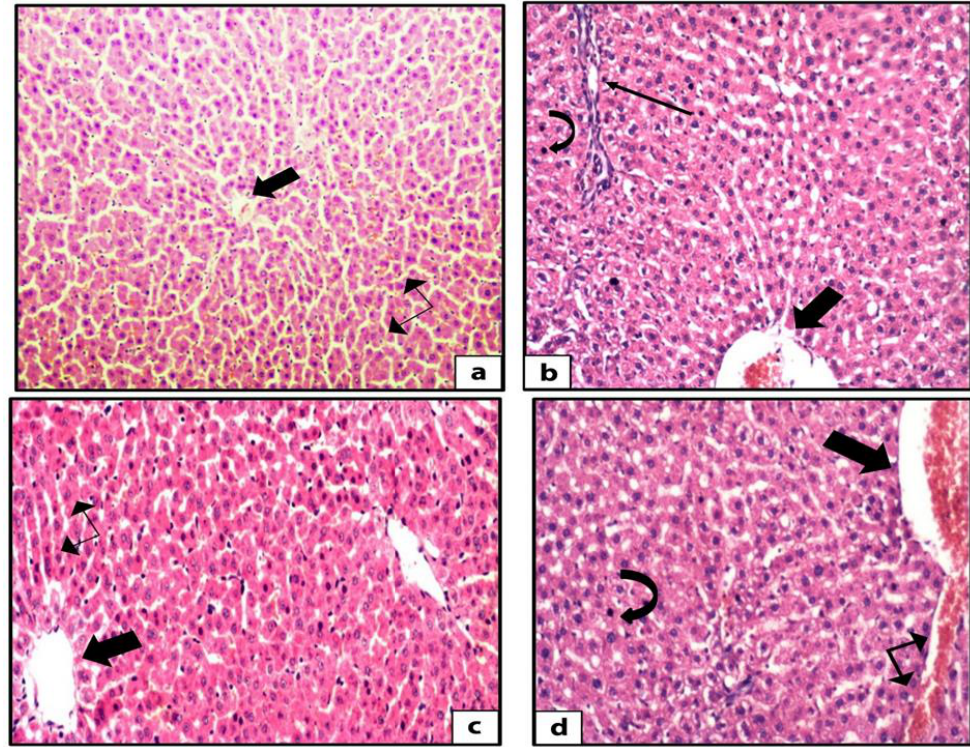
Figure 1. Photomicrographs of H&E-stained rat liver sections. The control rat liver shows branching and anastomosing cords of hepatocytes radiating from the central vein (thick arrow) with blood sinusoids (double head arrow) in between the cords (H&E ×200) ( a ). The sections of rat liver in DEX group showed disturbed arrangement of hepatocytes, multiple lipid droplets in between the hepatocytes, dilated congested central vein (thick arrow), mixed inflammatory infiltrate (thin ar- row), and some hepatocytes with dark pyknotic nuclei (curved arrow) (H&E ×400) ( b ). The liver sections from DEX + LCHF group showed branching and anastomosing cords of normal hepatocytes radiating from the non-congested central vein (thick arrow), normal non-congested blood sinusoids (double-head arrow), and few lipid droplets (H&E ×400) ( c ). The sections of the liver of DEX + HCLF rats show multiple lipid droplets dilated congested central vein (thick arrow), dilated congested hepatic sinusoids (double-head arrow), and some hepatocytes with dark pyknotic nuclei (curved arrow) (H&E ×400) ( d ). DEX: rats treated with dexamethasone to induce metabolic syndrome; DEX + LCHF: rats treated with dexamethasone to induce metabolic syndrome and fed on low-carbohy- drate high-fat diet; DEX + HCLF: rats treated with dexamethasone to induce metabolic syndrome and fed on high-carbohydrate low-fat diet.